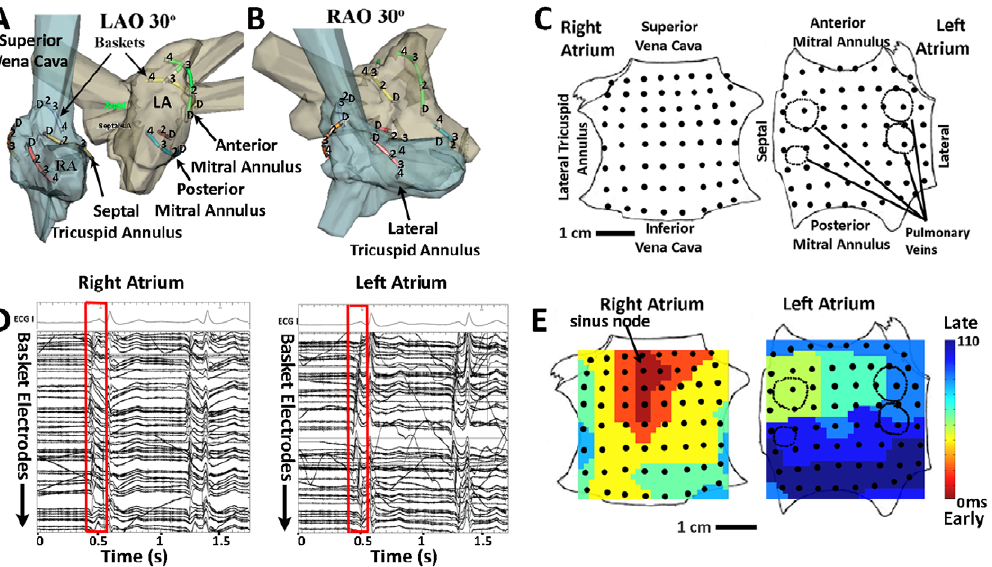
Figure 1. Electrical and Anatomic Mapping of Human Atria. A . Basket catheter splines are represented as colored lines registered within the right (blue) and left (grey) atria in left anterior oblique and B . right anterior oblique projections. The figure shows alternate splines with positions D (distal) to 4 representing electrodes 1 to 8. C . Bi-atrial schematic showing right atrium as if opened at its poles and left atrium as if opened at its equator, with electrode positions (black dots). D . ECG leads I, aVF and V1 and electrograms of one sinus rhythm beat (red box) captured by baskets in right and left atrium. E . Maps of sinus rhythm activation (isochrones) from high right atrium (sinus node) to low lateral left atrium created from bi- atrial basket recordings.